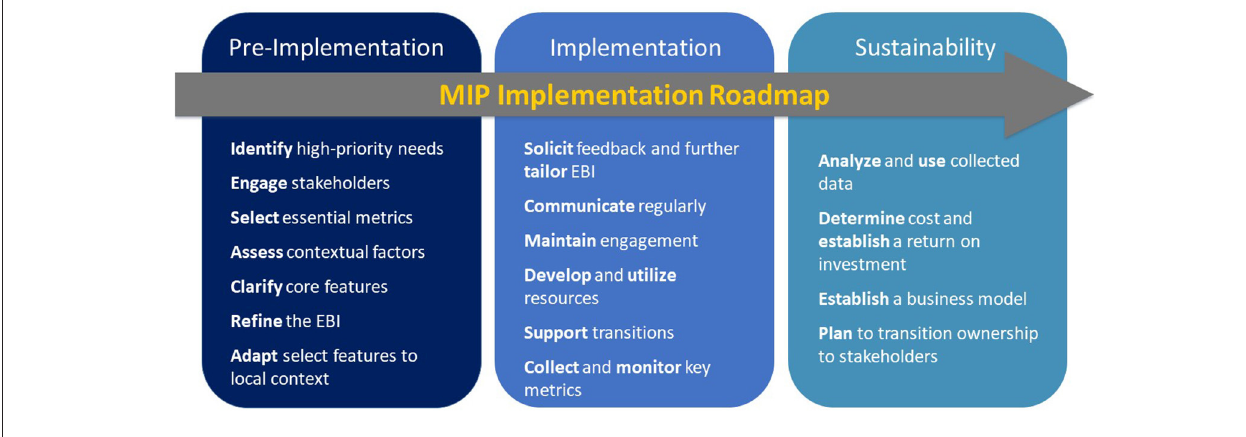
FIGURE 1 | MIP Implementation